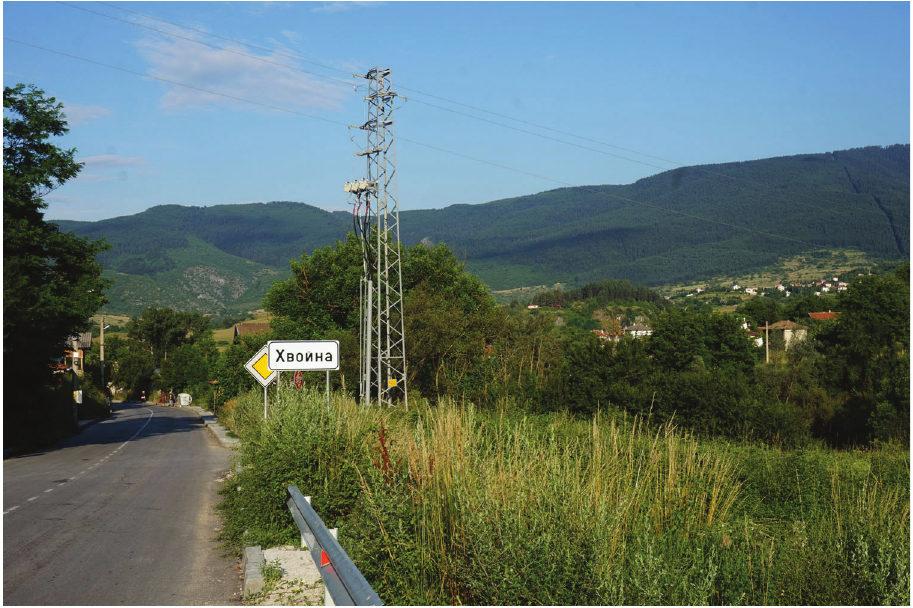
Figure 36. Hvoyna, Bulgaria, type locality of P. orphicus orphicus , 2 July 2016. Photo by E. Pazhenkova.